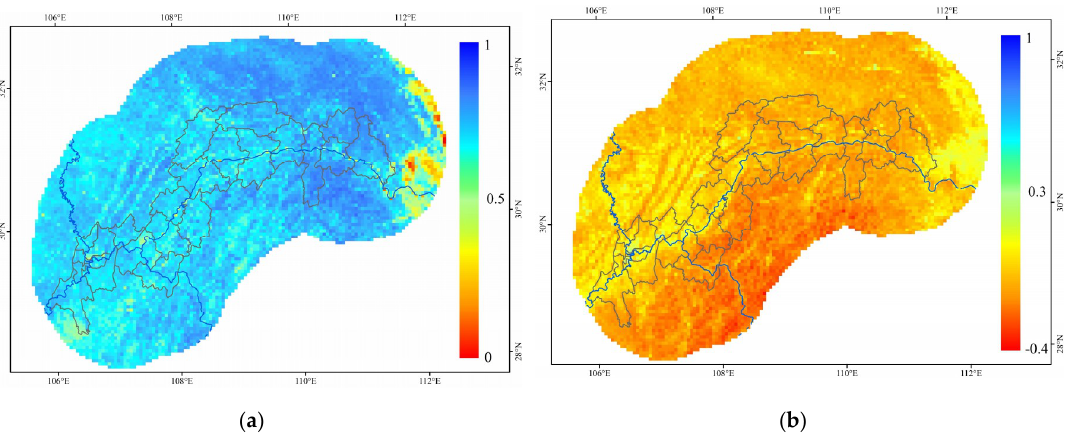
Figure 5. Partial correlation coefficient of NDVI–precipitation and NDVI–temperature (Total series). ( a ) partial correlation coefficient of NDVI–temperature; and ( b ) partial correlation coefficient of NDVI–precipitation.